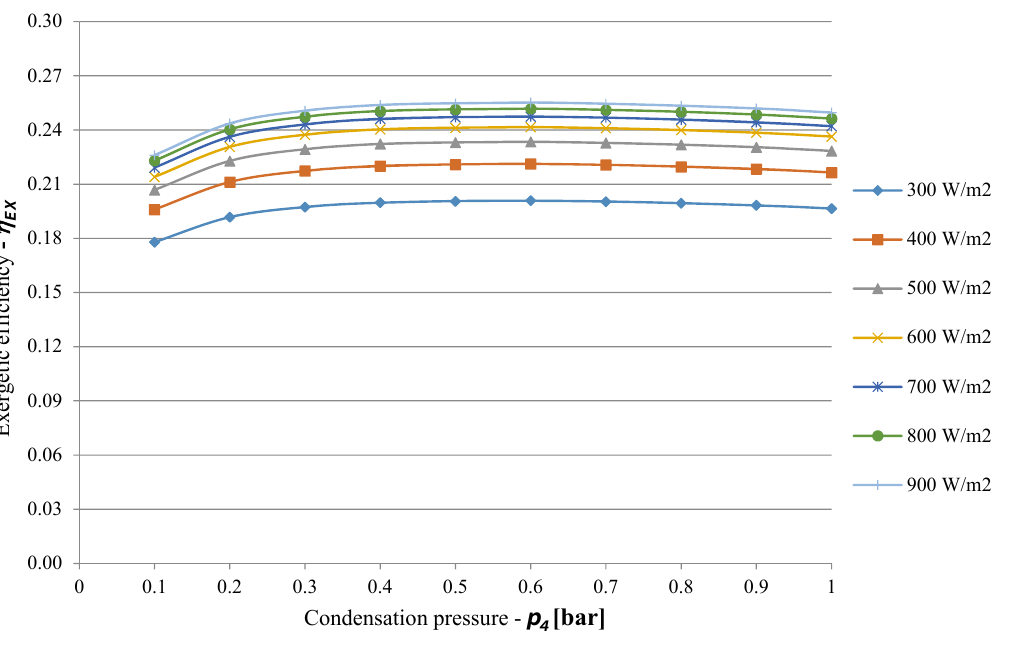
Figure 9. Exergetic efficiency versus condensation pressure under increasing solar radiations when the evaporation temperature is set at 170 °C.